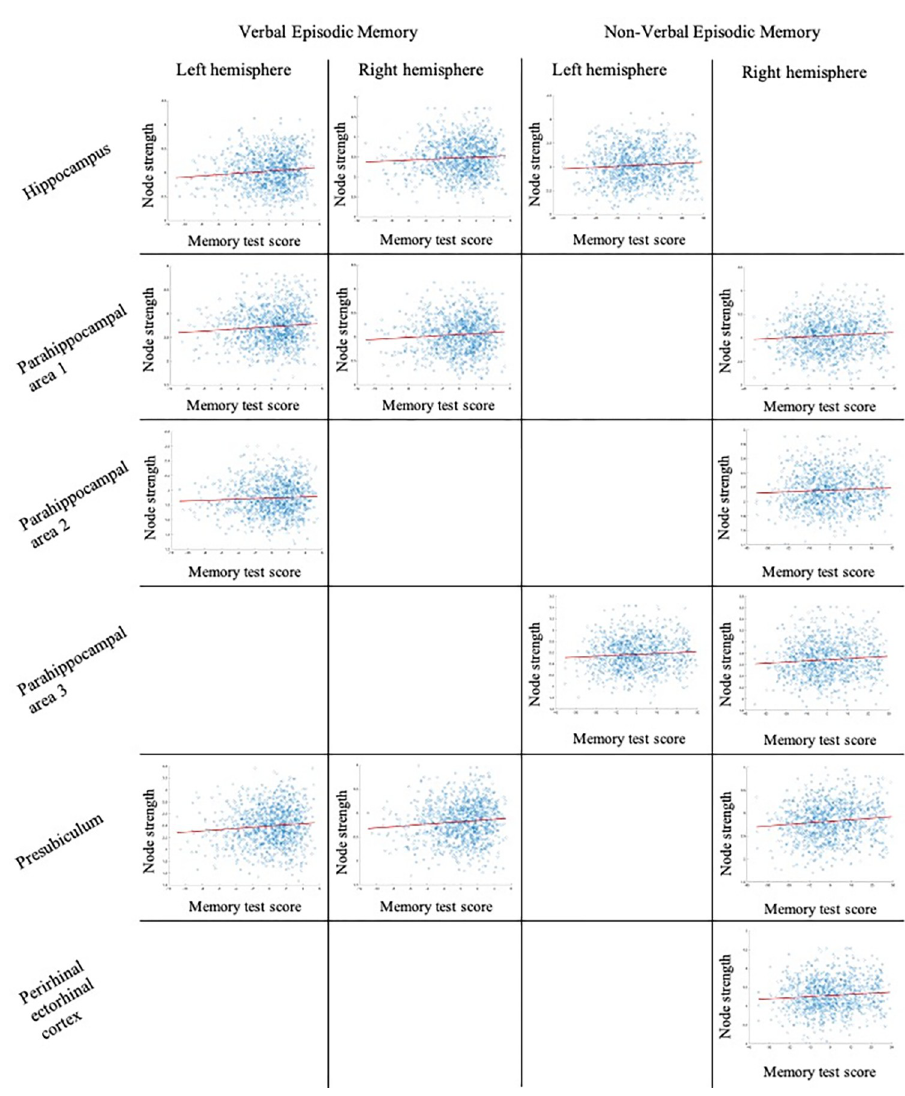
Fig 2. Winsorized node strength by residualized episodic memory test performance. Node strength values are winsorized to ± 3 standard deviations. Episodic memory test values are the residualized scores after accounting for